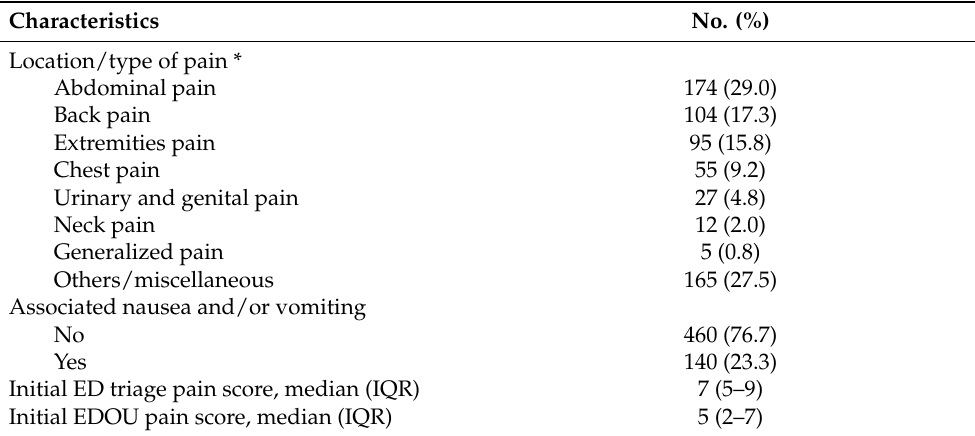
Table 2. Characteristics of cancer patients placed in an emergency department observation unit with pain.